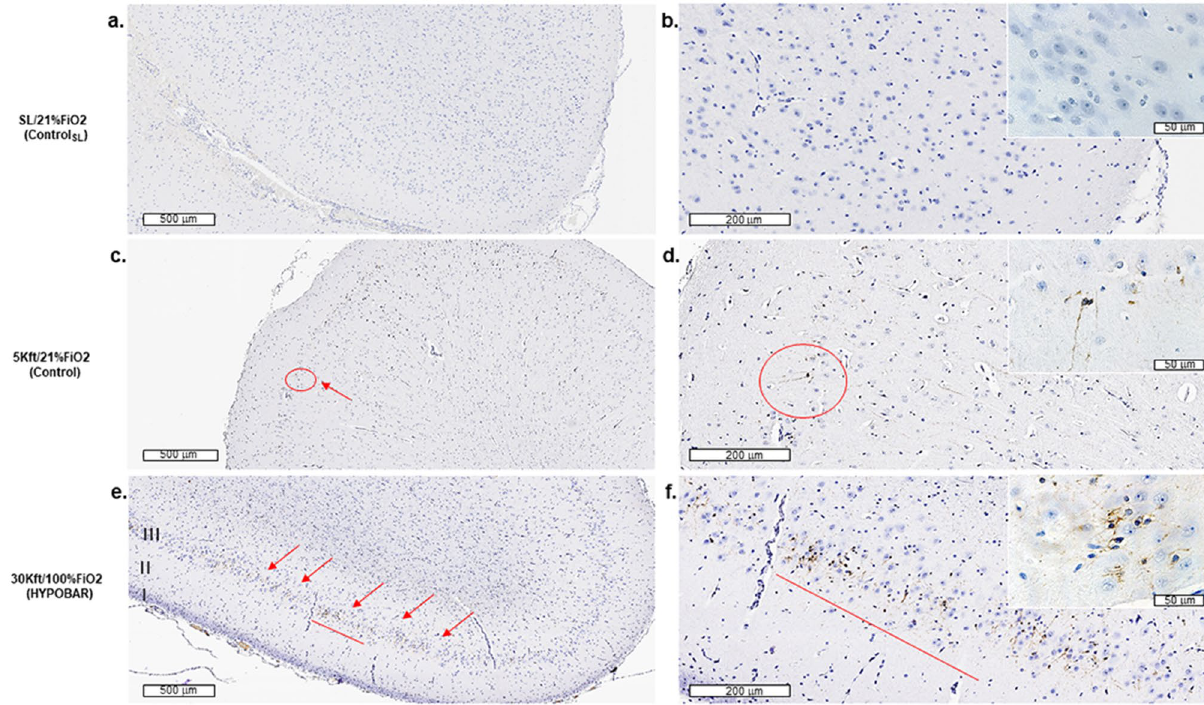
Figure 2. Immunohistochemistry (IHC) outcomes of the AT8 antibody in the left parietal cortex of minipig brains exposed to different oxemic and barometric conditions. Panel ( a – f ) show sections of the left parietal cortex at a lower level of magnification [at a scale of 500 microns (µm)] across all three analyzed experimental conditions. Panel ( b ), ( d ), ( f ) include upper right insets at a higher level of magnification [at a scale of 50 microns (µm)]. I, II, III indicate cortical layers. Red signals indicate the presence of AT8 positive cortical cells. Note the higher level of AT8-positive cortical cells in the 30ft/100%FiO 2 (HYPOBAR) group. SL sea level, FiO 2 fraction inspired oxygen, HYPOBAR nonhypoxic-hypobaric condition, ft feet, ControlSL SL/21%FiO 2 , Control 5Kft/21%FiO 2